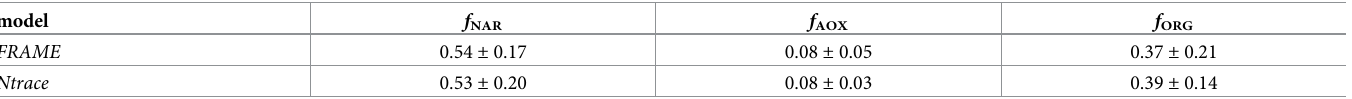
Table 9. Comparison of the results of the natural abundance nitrite model ( FRAME ) and the reference values based on 15 N traced studies ( Ntrace ). Mean values with standards deviation (1 σ ) of sources contribution are given.